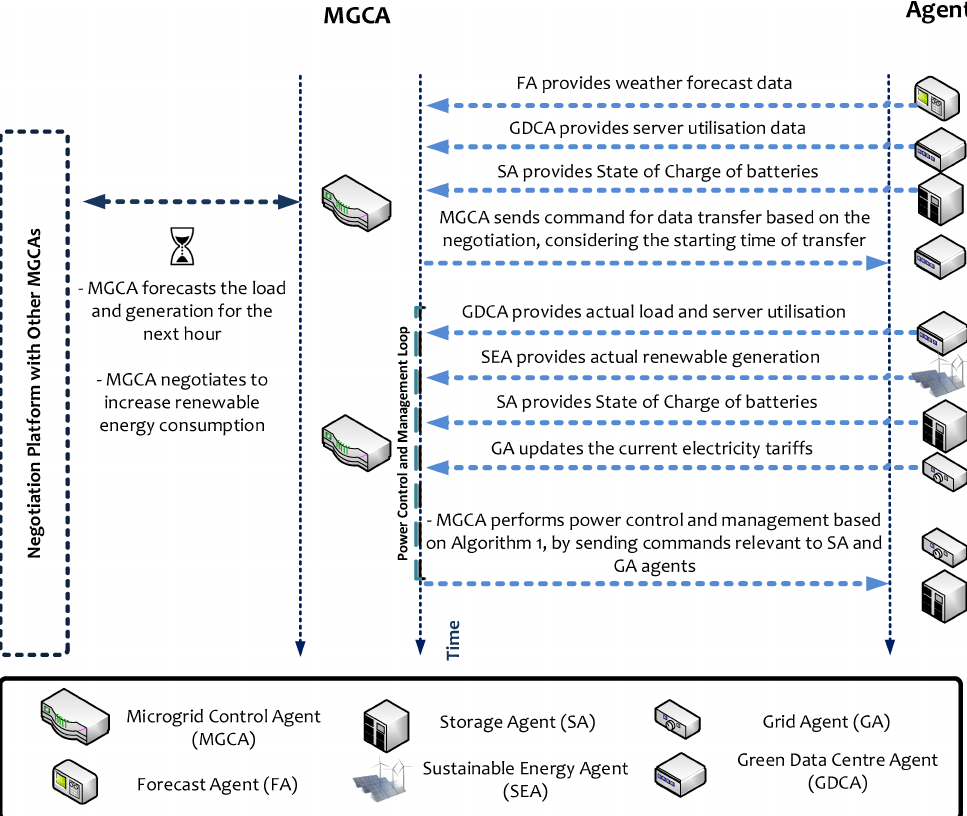
Figure 2. Schematic diagram of the hourly communications between the agents.